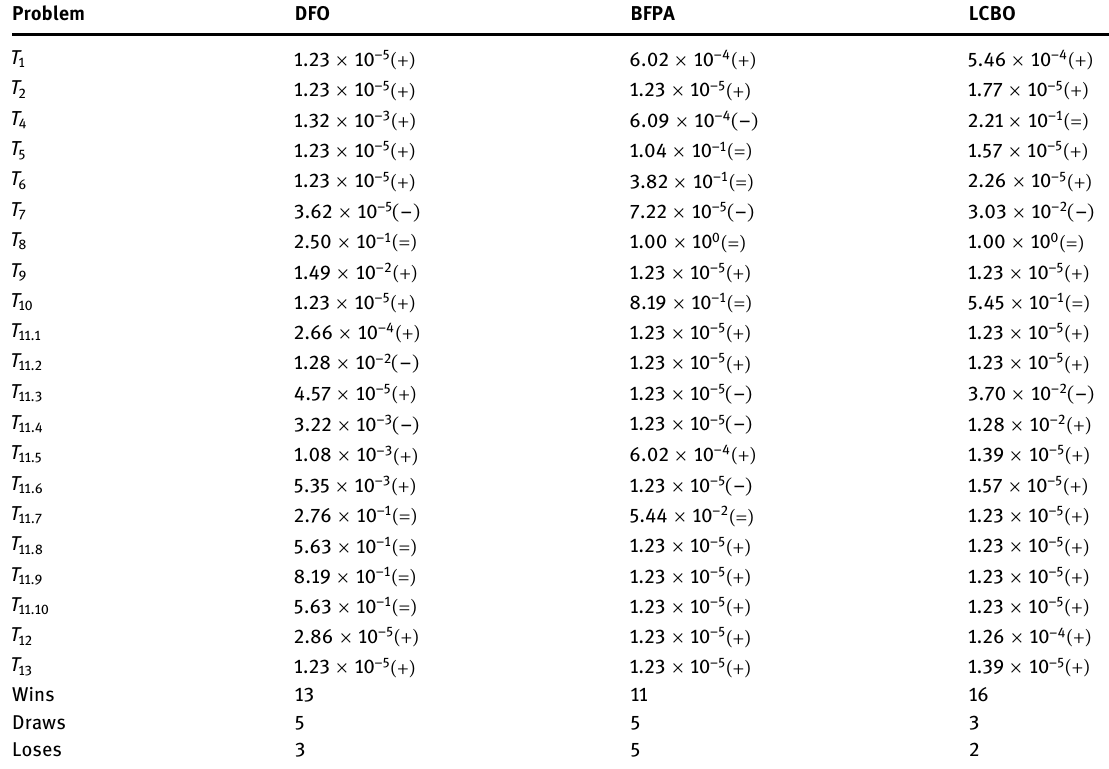
Table 12: The CEC 2011 statistical analysis showing the Wilcoxon test p -